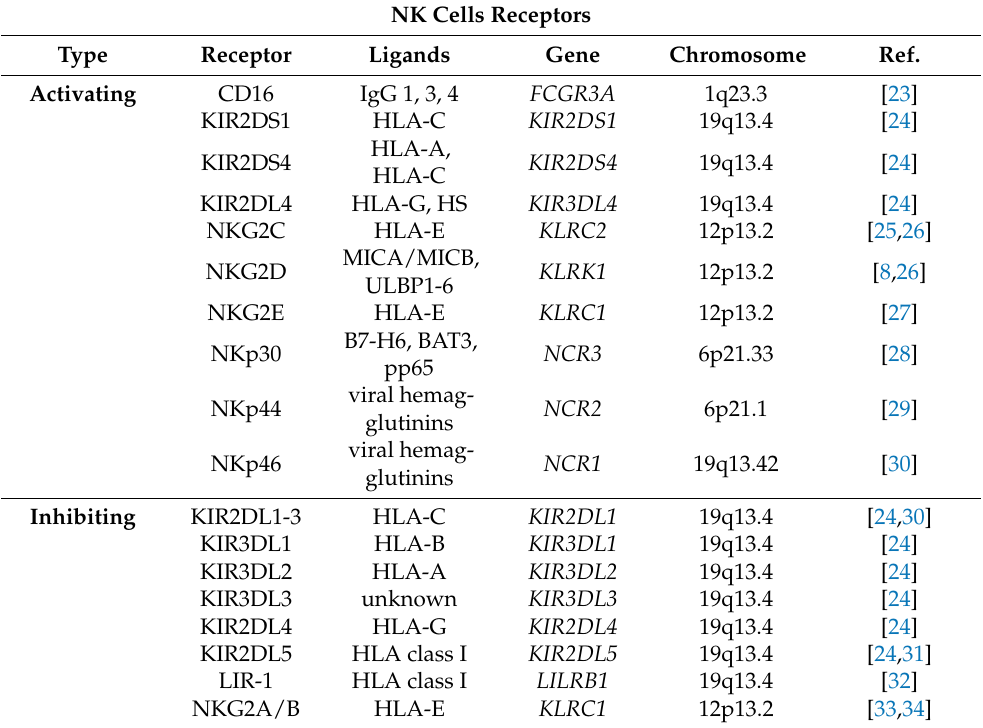
Table 1. NK cells receptors and their